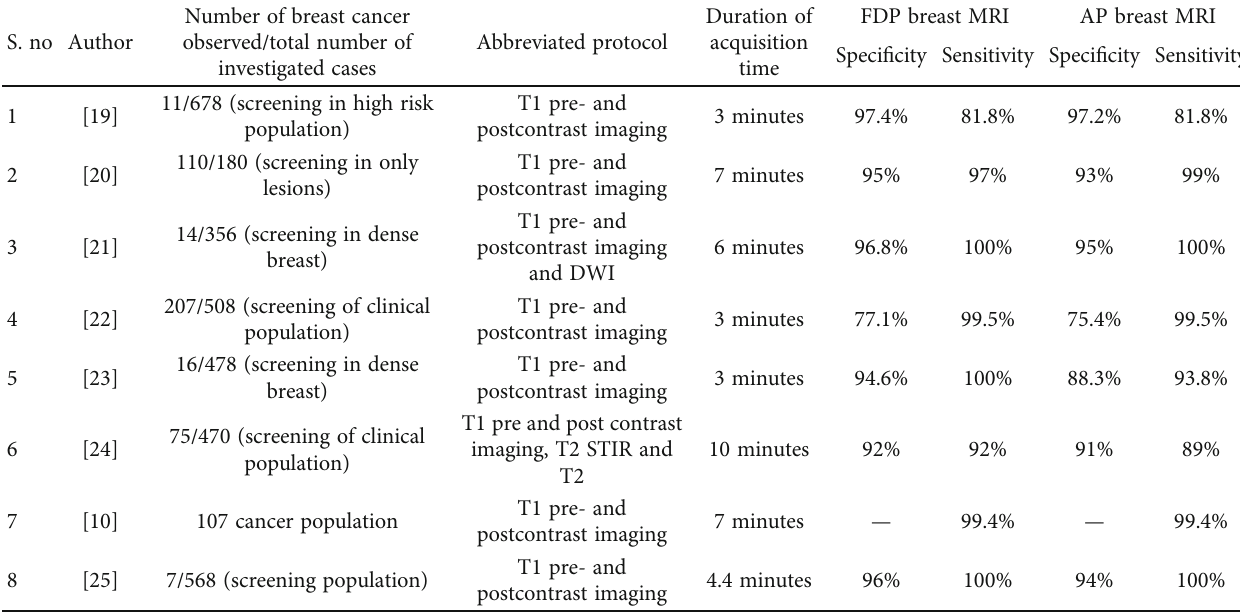
Figure 1: Shorter MR sequences of AP breast MRI protocol over FDP [16] Table 3: Comparison of AP with FDP for the detection of breast